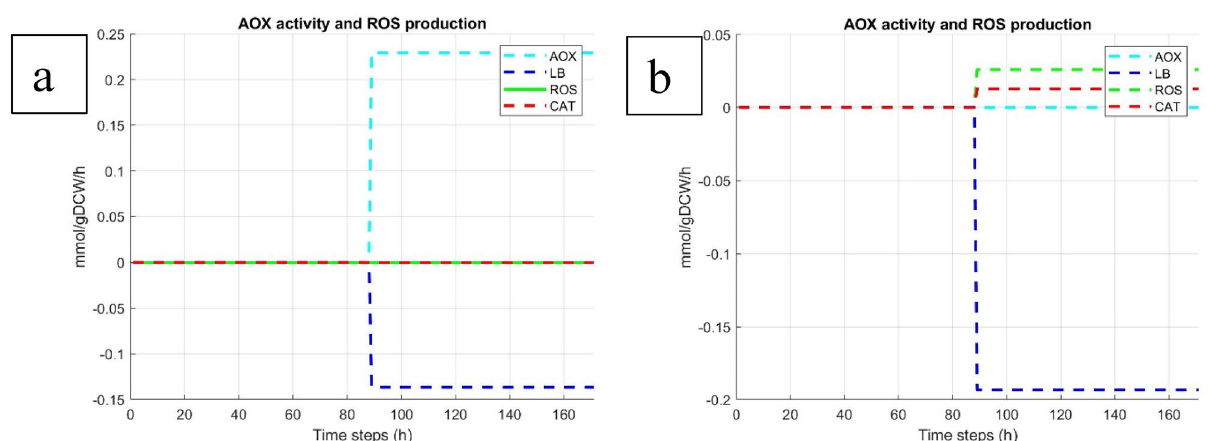
Figure 4. Simulated AOX and reactive oxygen species (ROS) production in normal condition ( a ) and in condition of optimized citrate production ( b ). Lipid bodies (LB) and ROS accumulation, catalase (CAT) activity increase on stat-phase concomitant with optimized citrate production. Fatty acid and alcohol oxidases contribute to ROS generation. On another hand catalase participates in cleaning ROS